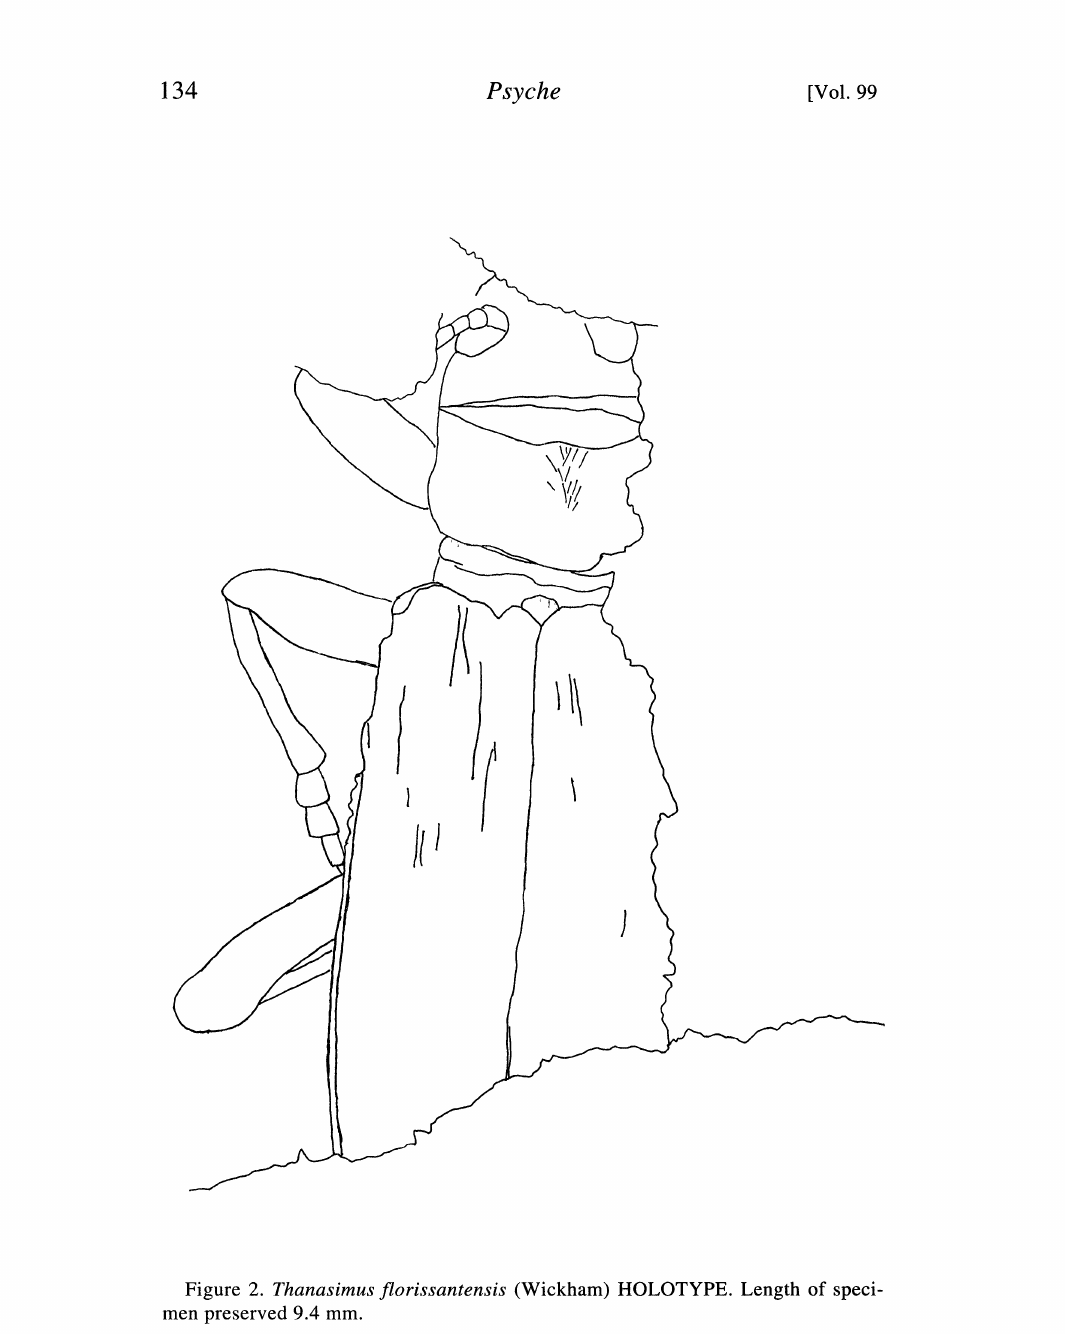
Figure 2. Thanasimus florissantensis (Wickham) HOLOTYPE. Length of speci- men preserved 9.4